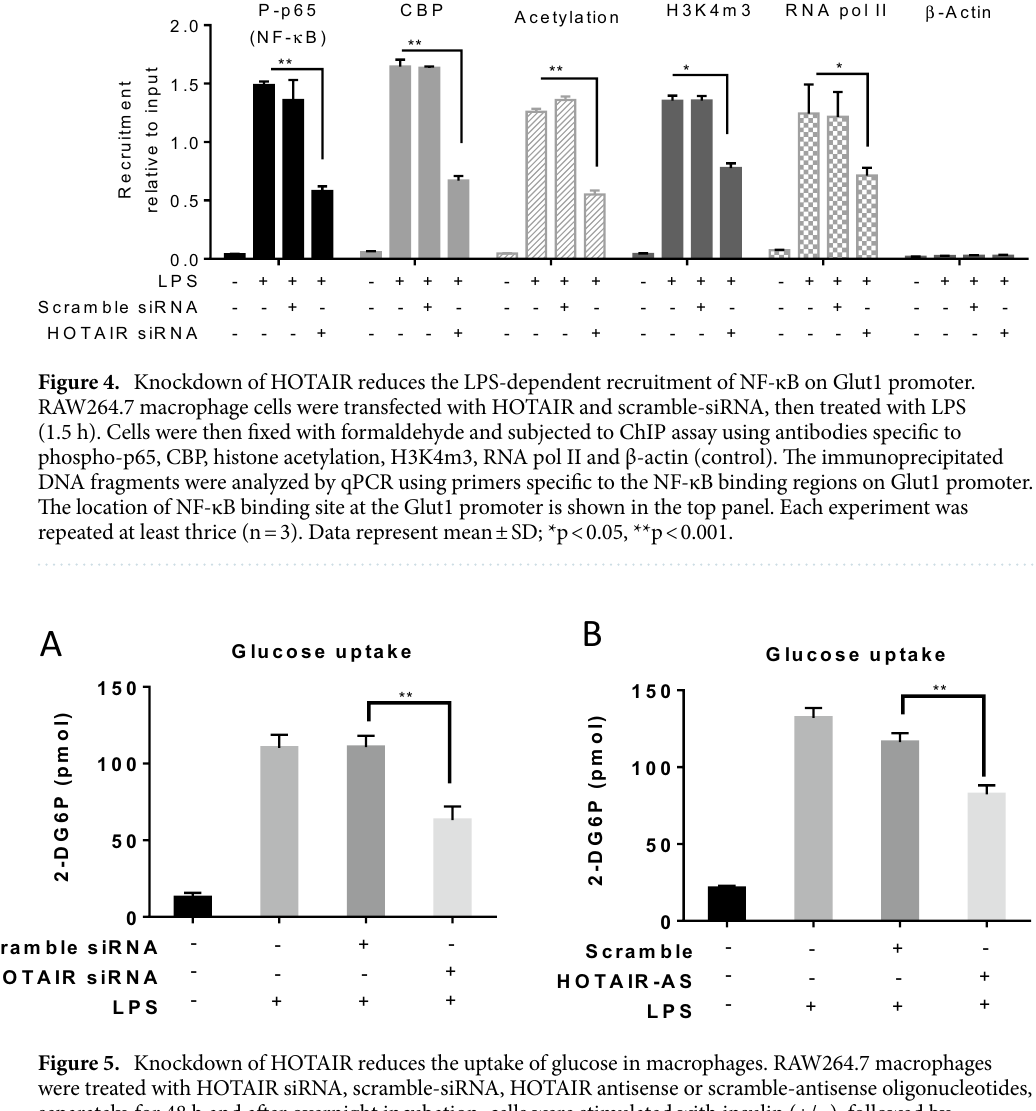
Figure 5. Knockdown of HOTAIR reduces the uptake of glucose in macrophages. RAW264.7 macrophages were treated with HOTAIR siRNA, scramble-siRNA, HOTAIR antisense or scramble-antisense oligonucleotides, separately, for 48 h and after overnight incubation, cells were stimulated with insulin (+/−), followed by 2-deoxyglucose addition for 20 min. 2-DG6P was oxidized and that generates NADPH, which was quantified calorimetrically (measured at 412 nm in a microplate reader). Panels A and B show the glucose uptake analysis under siRNA and antisense-meditated HOTAIR knockdown respectively. Each experiment was repeated at least thrice (n = 3). Data represent mean ± SD; *p < 0.05, **p <